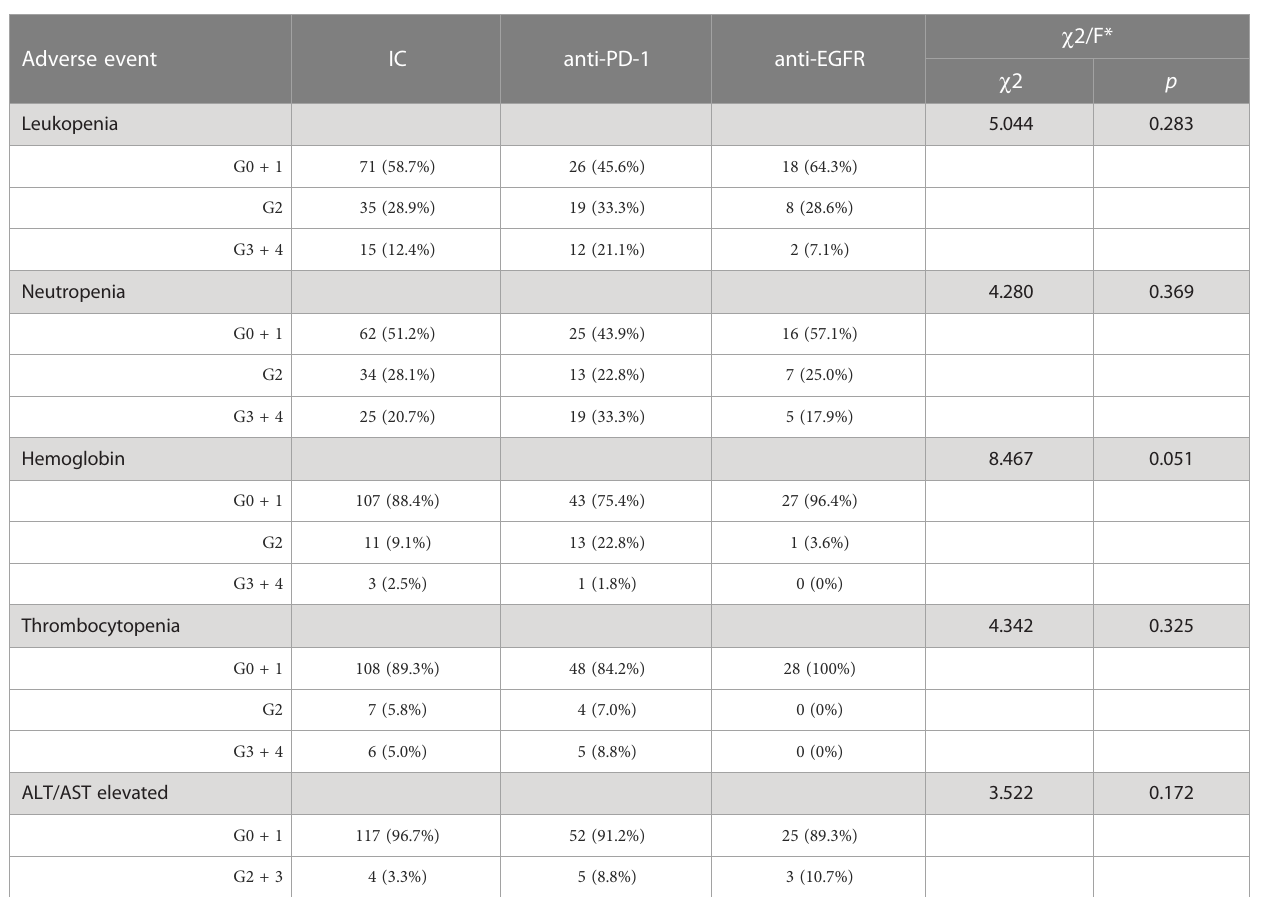
TABLE 6 Major adverse events during induction chemotherapy.